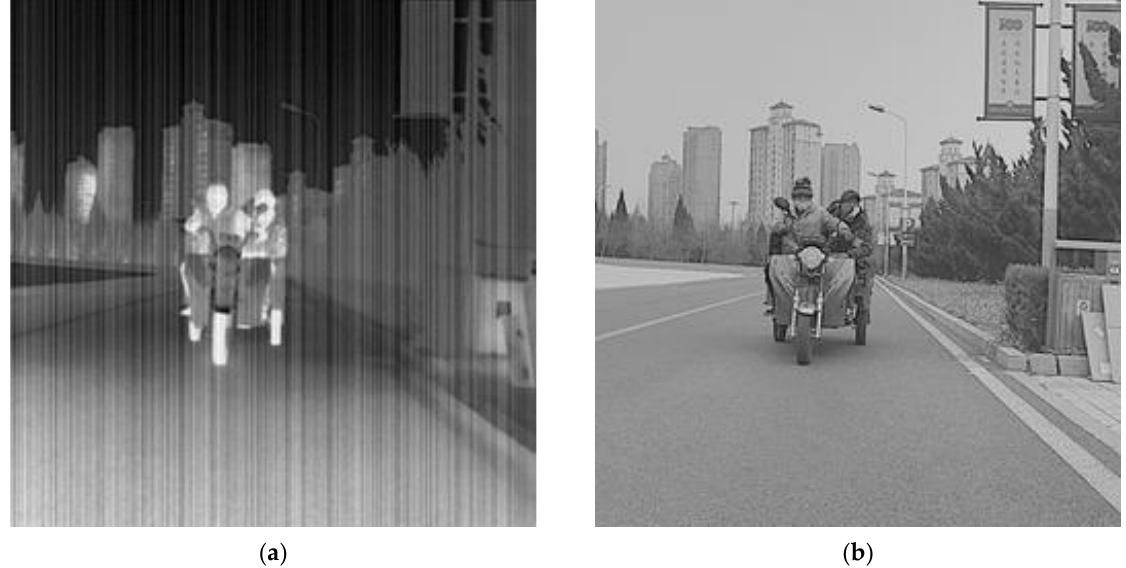
Figure 12. Network visual test image. ( a ) Input infrared image to be corrected; ( b ) input visible image.